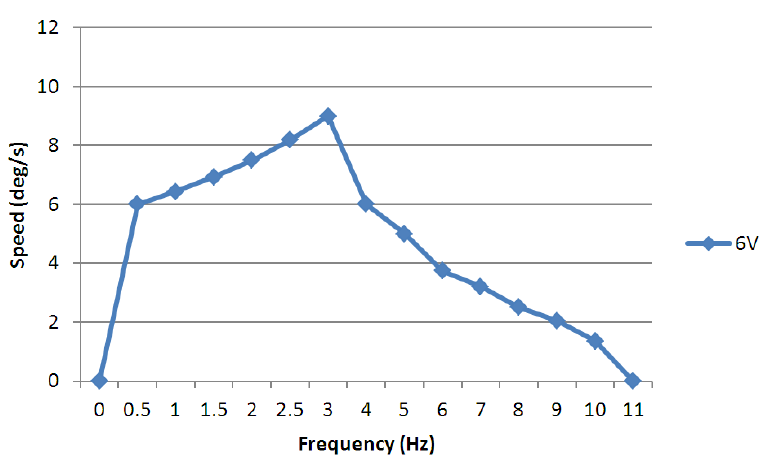
Figure 23. Experimental rotating speeds.